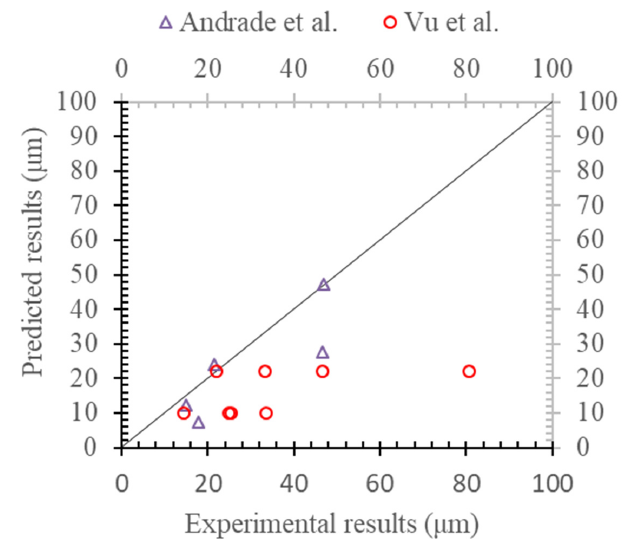
Figure 8. Radial loss with uniform corrosion model.